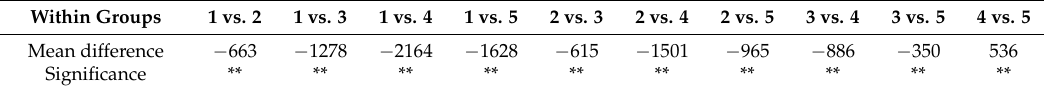
Table 7. Tukey’s honest significant difference (HSD) test results for high-temperature rutting test. Within